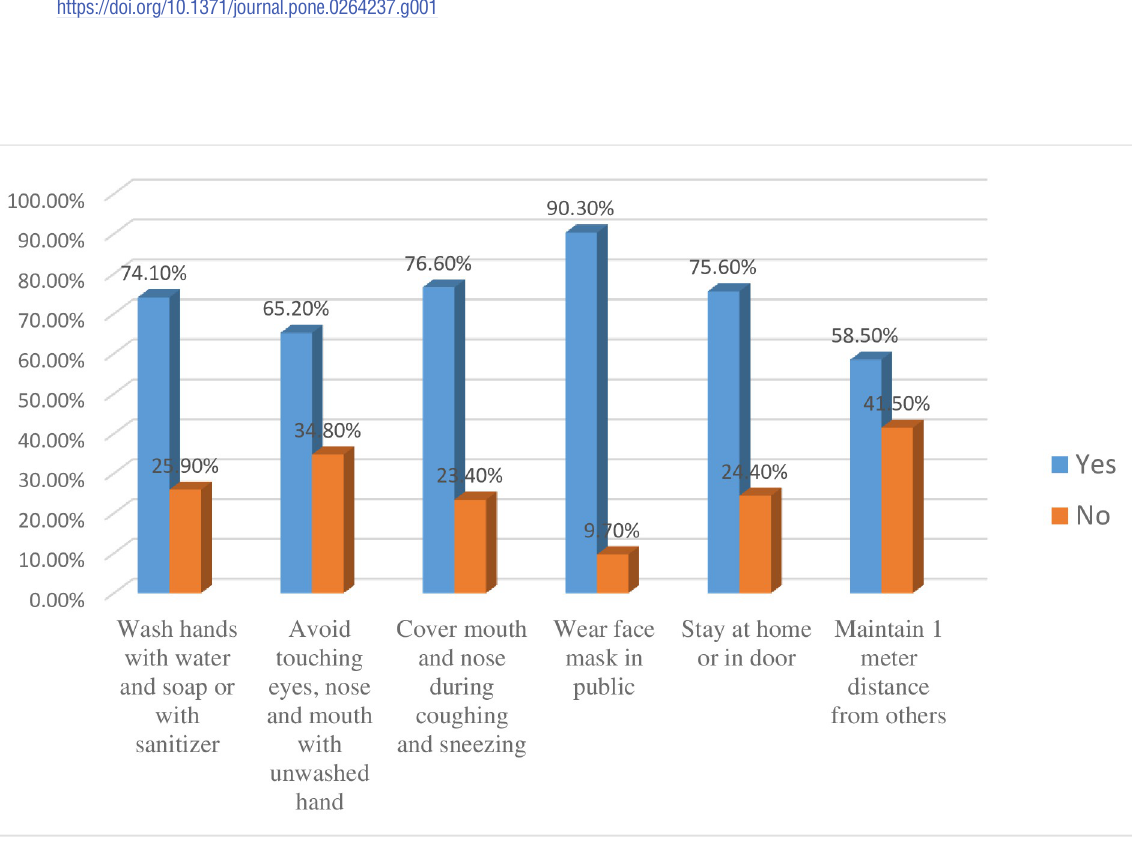
PLOS ONE | https://doi.org/10.1371/journal.pone.0264237 March 2, 2022 8 /